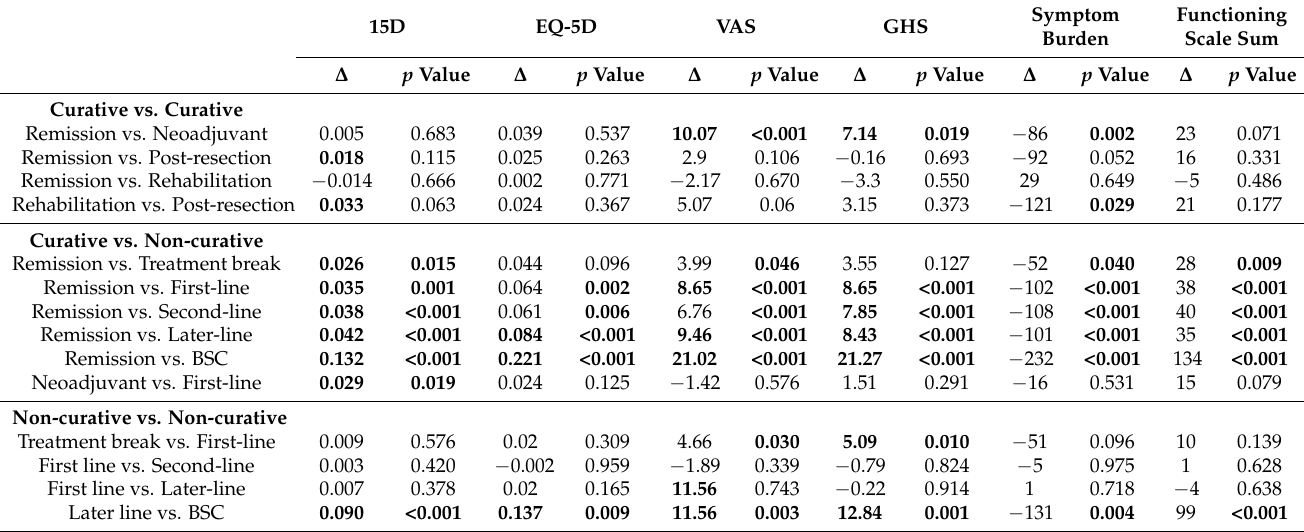
Table 3. Comparisons of index measures between different treatment phases.